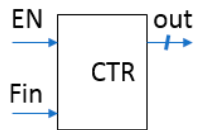
Figure 1. Gated counter for measuring frequency.